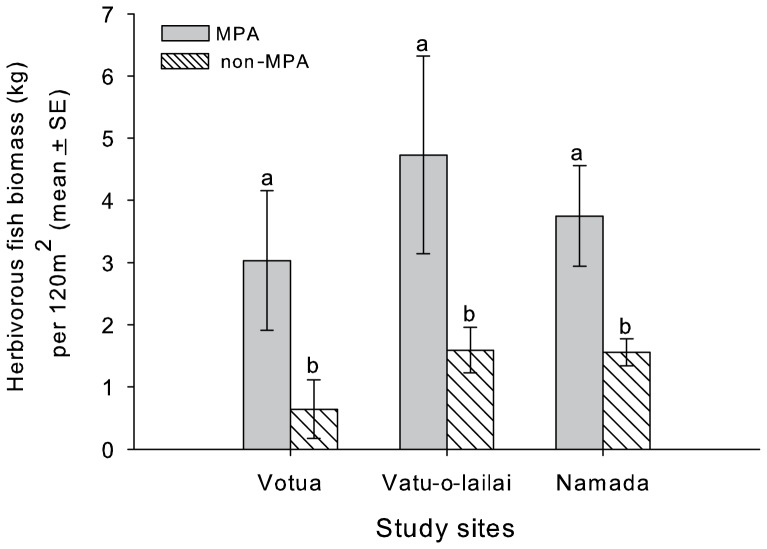
Biomass of herbivorous fishes in MPAs and non-MPAs at three sites along the Coral Coast, Fiji.Letters indicate significant groupings (p<0.05).